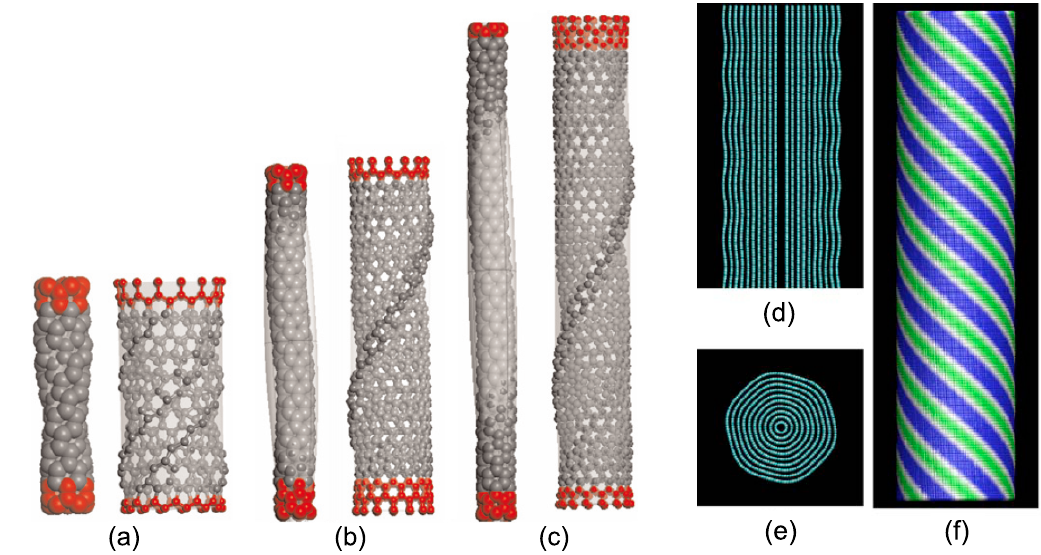
Figure 18. ( a )–( c ) Helical buckling of (5,0)@(14,0) DWNTs with lengths: ( a ) L = 1.095 nm; ( b ) 4.45 nm; and ( c ) 6.97 nm. For each tube length, the inner wall shows ordinary buckled patterns, whereas the outer wall exhibits nontrivial buckling modes associated with local rims; ( d )–( f ) Helical rippling deformation of a 10-walled nanotube (5,5)@ . . . @(50,50) of 34 nm in length and 3.4 nm in radius: ( d ) Longitudinal view; ( e ) Cross-sectional view; ( f ) Deformation map, with green for ridges and blue for furrows. Reprinted from References